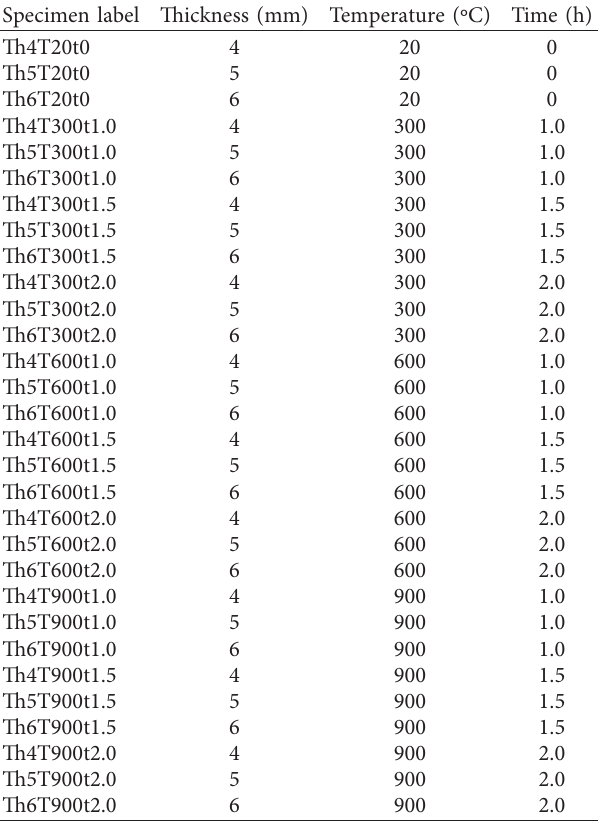
Table 1: Summary table of experimental control parameters.